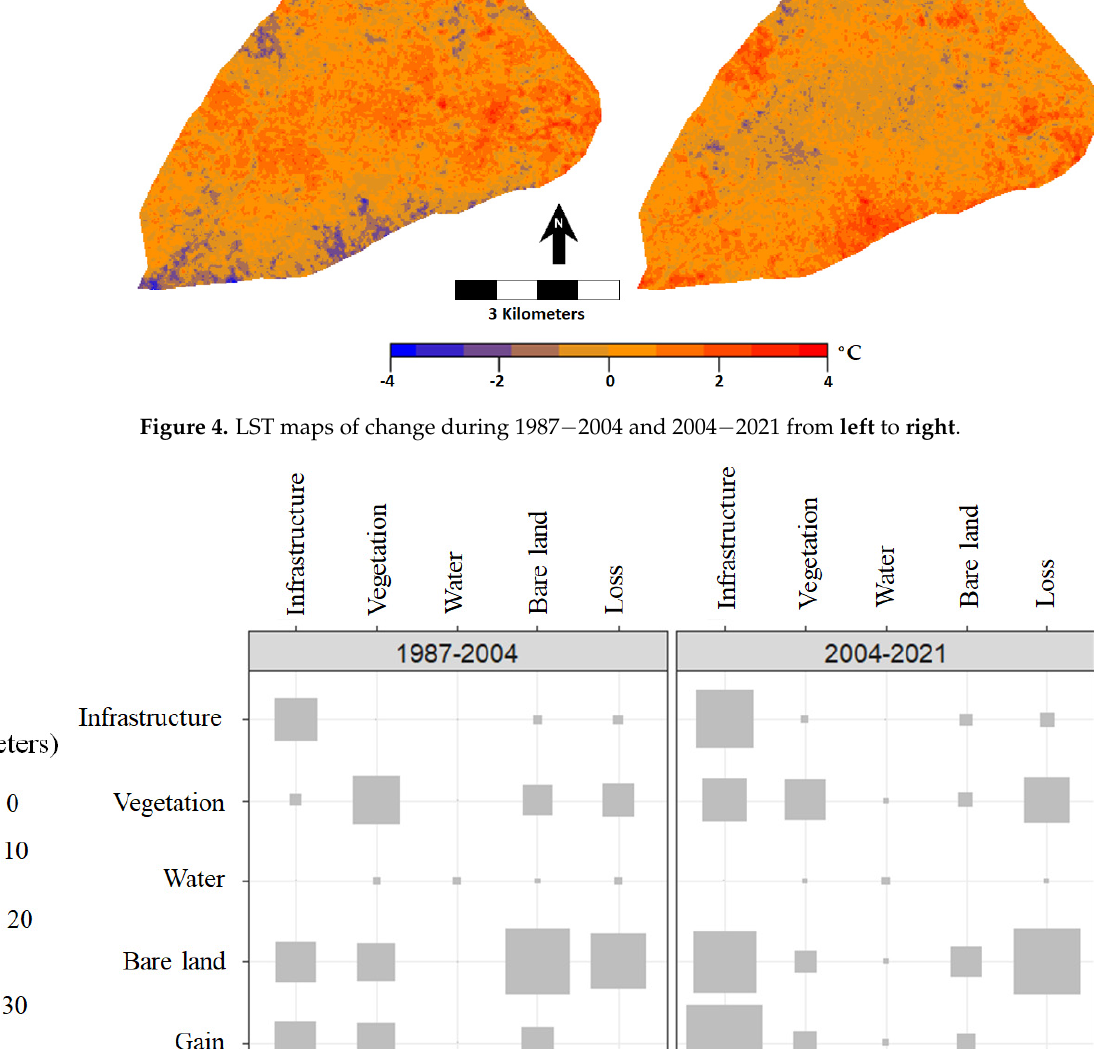
Figure 5. Transitional matrix during 1987 − 2004 and 2004 − 2021.